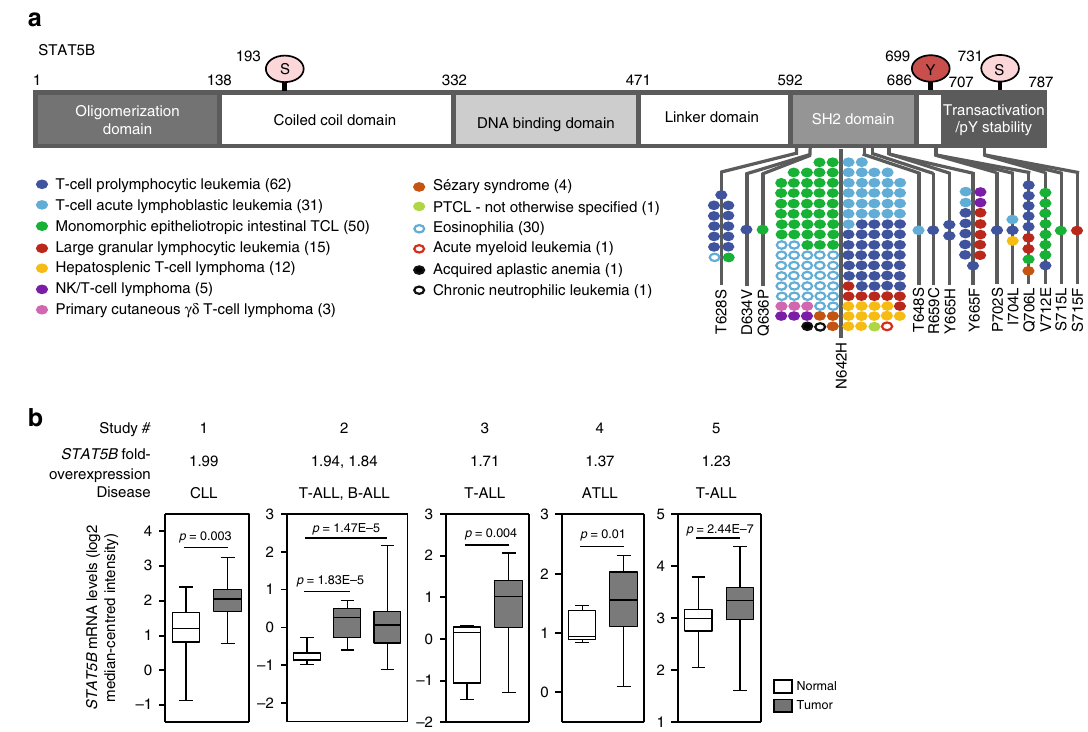
Fig. 1 STAT5B is overexpressed and mutated at hot-spot residues in hematopoietic cancers. a Schematic depicting mutations found within the SH2 and C- terminal domains of human STAT5B in patients with various hematological malignancies. Each dot is representative of one patient. Numbers in brackets denote the number of patients reported to harbor any of the STAT5B mutations shown, for each disease entity. b Box plots showing human hematopoietic cancers with signi fi cant upregulation of STAT5B mRNA in tumor cells, compared with tissue-matched normal control cells. Data were extracted from the Oncomine database, from the following studies: 1 Haslinger Leukemia (chronic lymphocytic leukemia, CLL); 2 Andersson Leukemia (T-cell